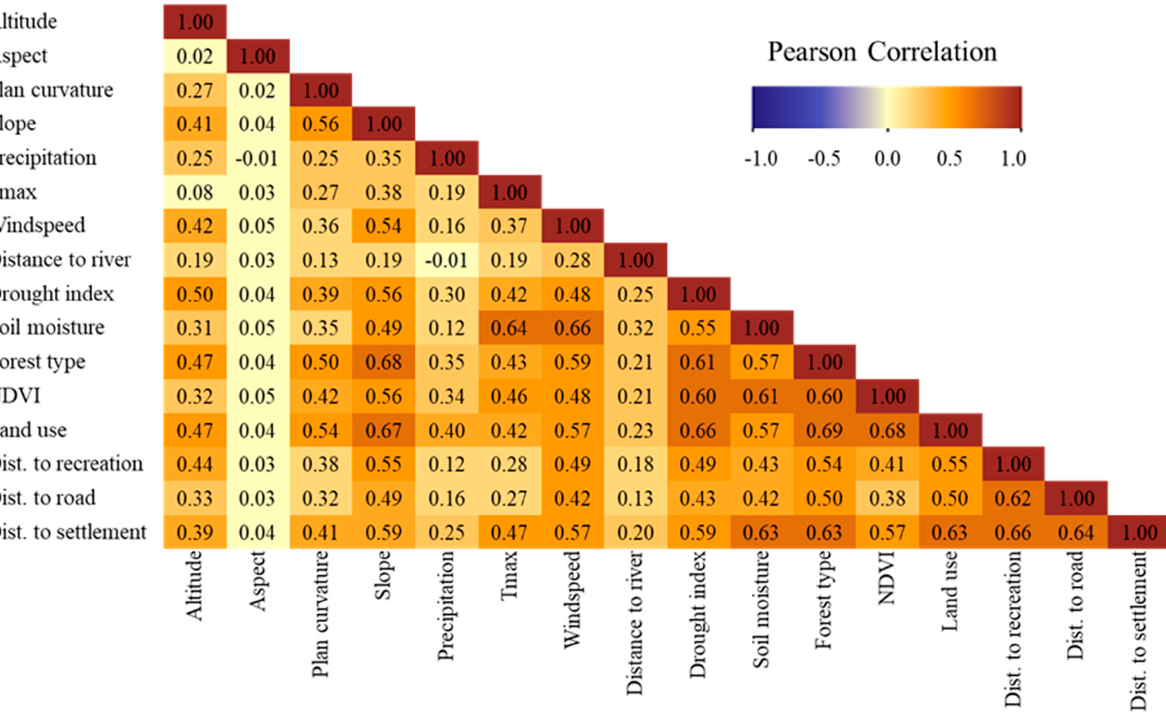
Figure 7. Pearson correlation between wildfire-driving factors.